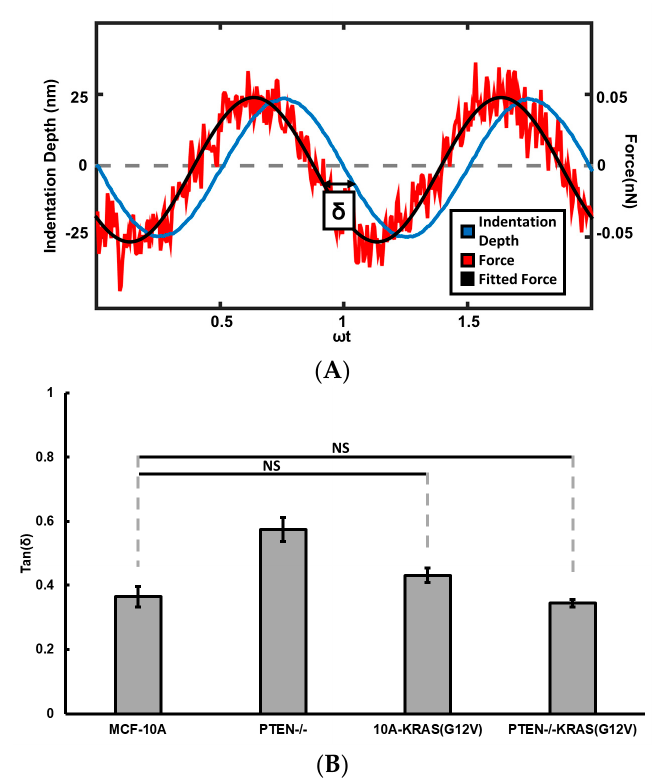
Figure 3. ( A ) Example oscillatory force (red) and indentation (blue) signals of a force curve, with phase shift δ depicted between the two signals. The force signal is fitted into a sinusoidal function of time as indicated by the black line. ( B ) Average loss tangent of control MCF-10A, PTEN − / − , 10A-KRAS(G12V), and PTEN − / − KRAS(G12V) cells seeded on glass. Number of cells measured: n = 16–35. NS signifies non-significant differences between two groups ( p > 0.05).